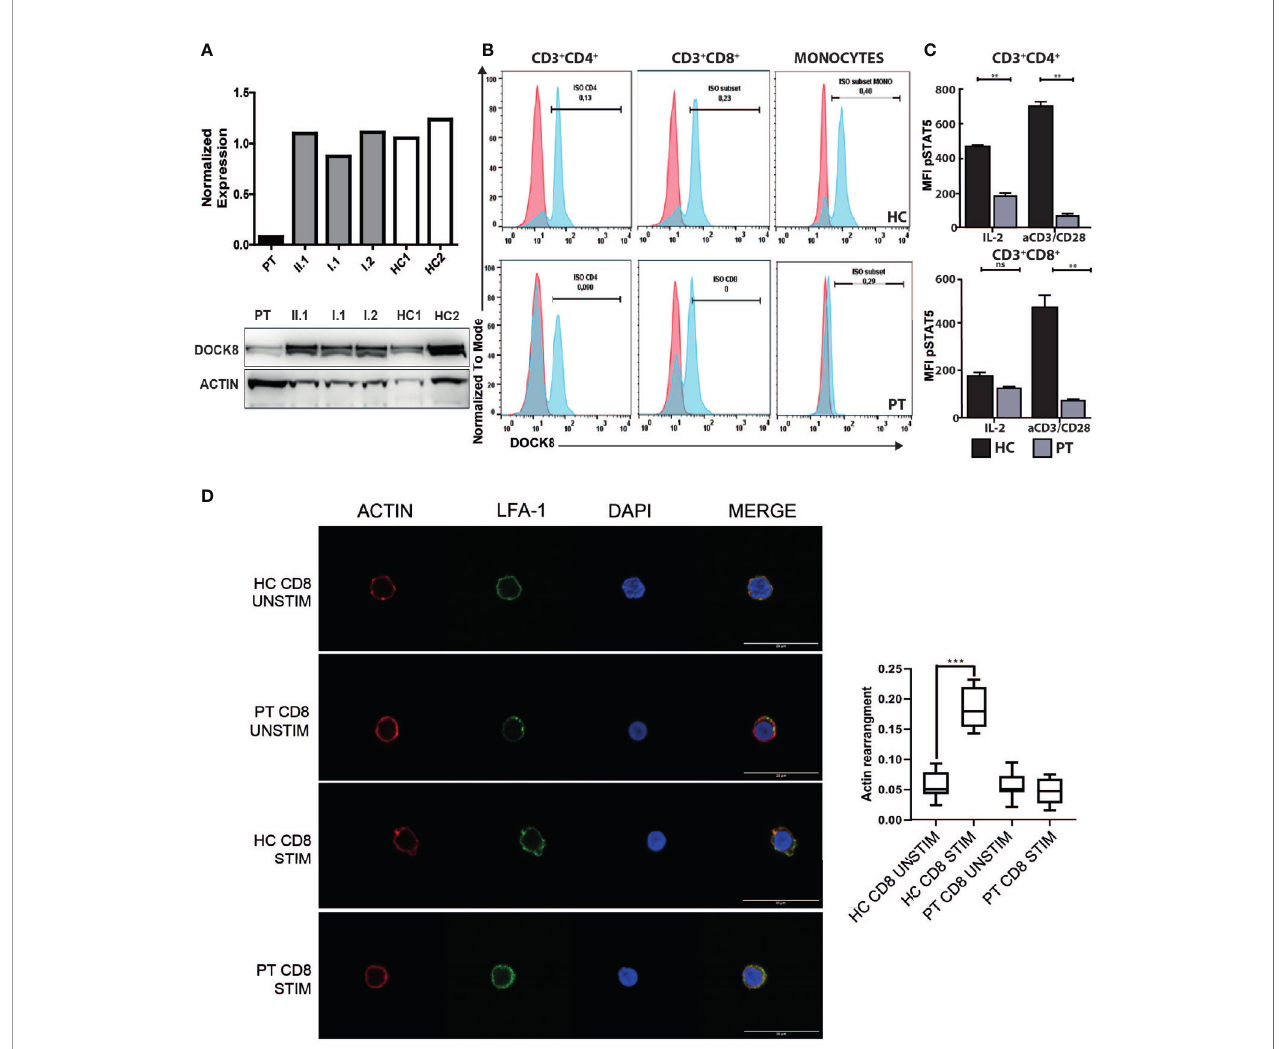
FIGURE 3 | Functional characterization of the DOCK8 variants. (A) Evaluation of DOCK8 levels in IL2-PHA expanded T-cell of the index patient, family members and two healthy controls (HC1 and HC2) by means of fl ow cytometry (upper panel; one representative experiment of 2 independent experiments) and western blot (lower panel; one representative experiment of 2 independent experiments). (B) Flow cytometric analysis of DOCK8 expression in peripheral T-cells and monocytes of the patient and a healthy control, showing hypomorphic DOCK8 expression in CD3 + CD4 + and CD3 + CD8 + . (representative experiment) (C) Reduction of STAT5 phosphorylation in patient ’ s peripheral CD4 + and CD8 + T-cells at baseline and following stimulation with IL2 or CD3/CD28 monoclonal antibodies. (one representative experiment performed in duplicates) (D) Representative images of Actin (Red), LFA-1 (green) and DAPI (Blue) staining on unstimulated or CD3/CD28 stimulated CD8 + cells from the index patient and a healthy donor (representative experiment). Scale bar: 20um. In the right panel, box plots show the quanti fi cation of actin signal in analyzed samples. (**p < 0.01; ***p < 0.001). HC, healthy control; PT, patient; Stim, stimulated; Unstim, unstimulated. NS, not signi fi